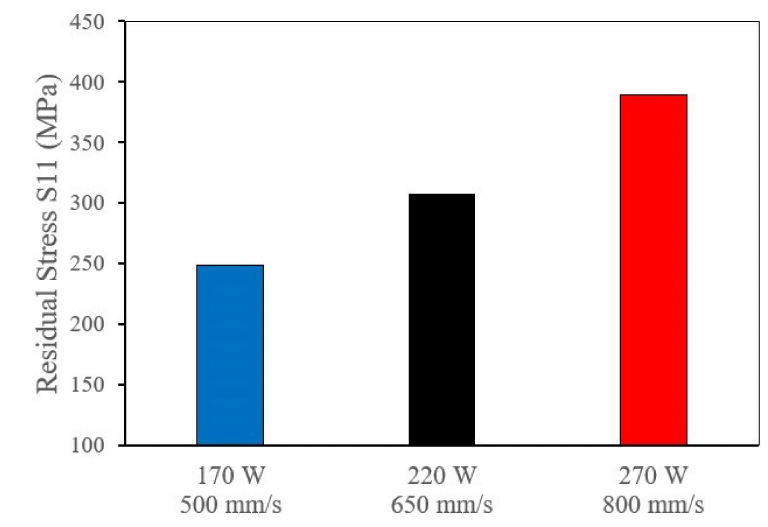
Figure 37. Surface RS at a constant energy density of 2.82 J/mm 2